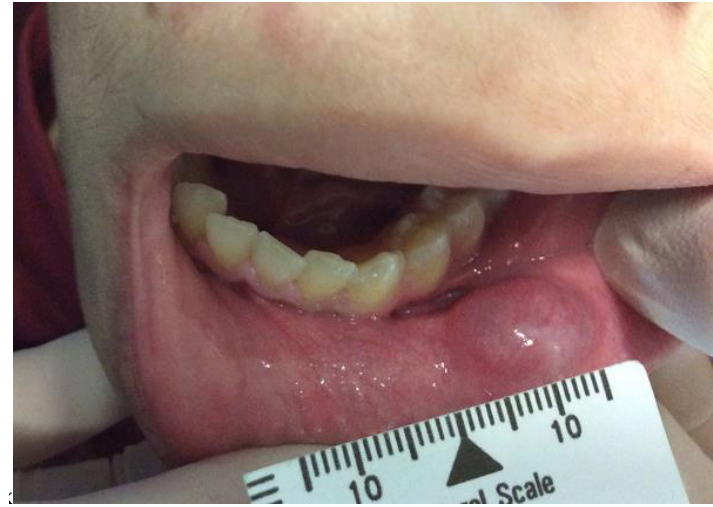
Figure 1. Male patient of 14 years showed swelling of the lower lip mucosa, of elastic consistency, red/blue color, not fluctuating and painless. The lesion measured 10 mm.